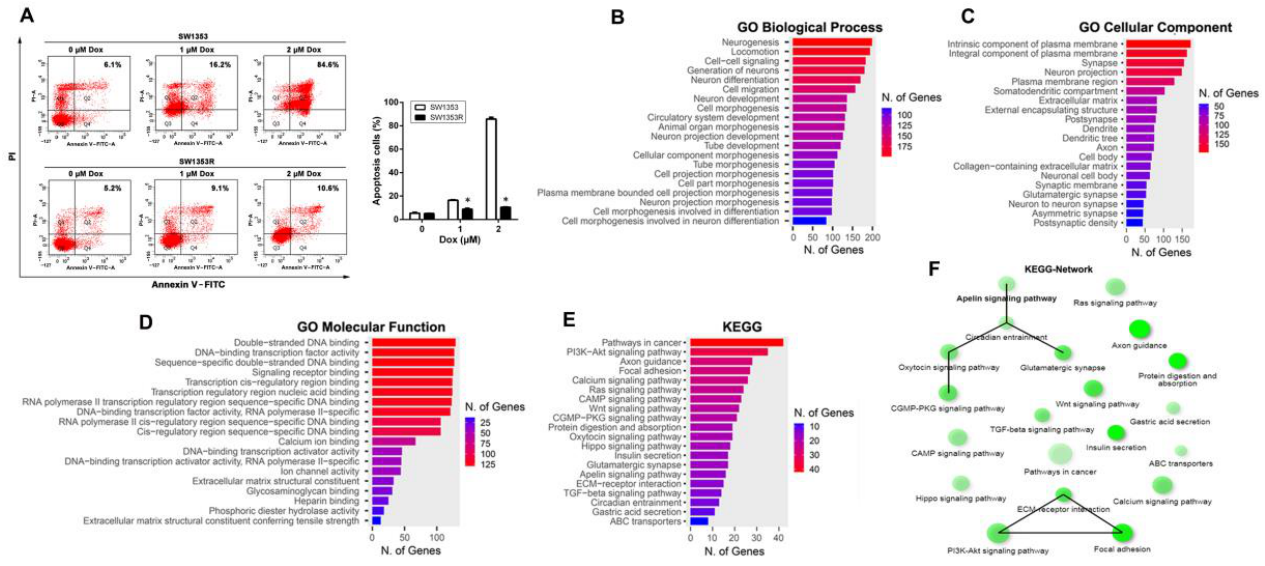
Figure 1. APLN was involved in chondrosarcoma progression. ( A ) SW1353 and SW1353R cells were treated with increasing doses of Dox (0 – 2 μM ) for 24 h and cell were stained with annexin V-FITC and PI. Percentages of apoptosis cells were analyzed by flow cytometry. Data were expressed as mean ± SEM ( n = 3). * p < 0.05 compared with SW1353 cells. ( B – E ) SW1353 and SW1353R cells were analyzed using RNA sequencing, and a total of 1438 genes were selected using thresholds of |log 2 fold change (FC)| > 2 and padj value < 0.05 for bioinformatics analysis of ShinyGO. Those genes were significantly upregulated in SW1353R cells compared to SW1353 cells. Bar plot shows the numbers of genes corresponding to their functional pathways by GO enrichment analysis. ( B ) Biological process of GO analysis; ( C ) cellular component of GO analysis; ( D ) molecular function of GO analysis; ( E ) KEGG pathways analysis. ( F ) Visualization of the relationship among KEGG pathways using